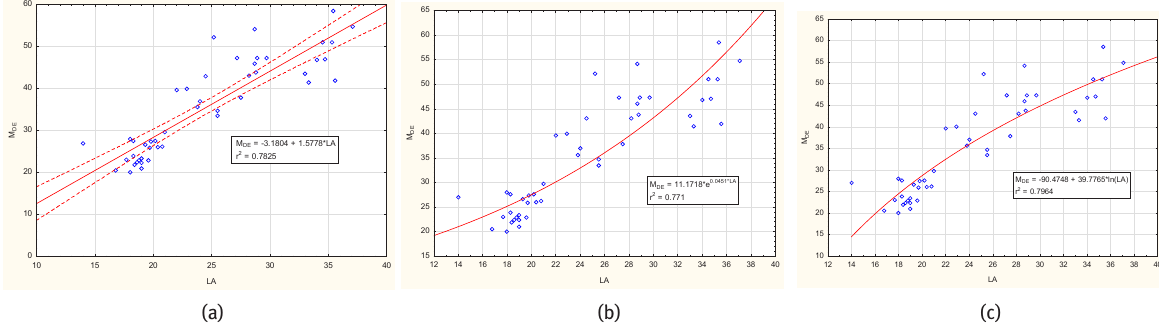
Figure 7: Function fitting for Magura sandstone: (a) linear, (b) exponential and (c) logarithmic.